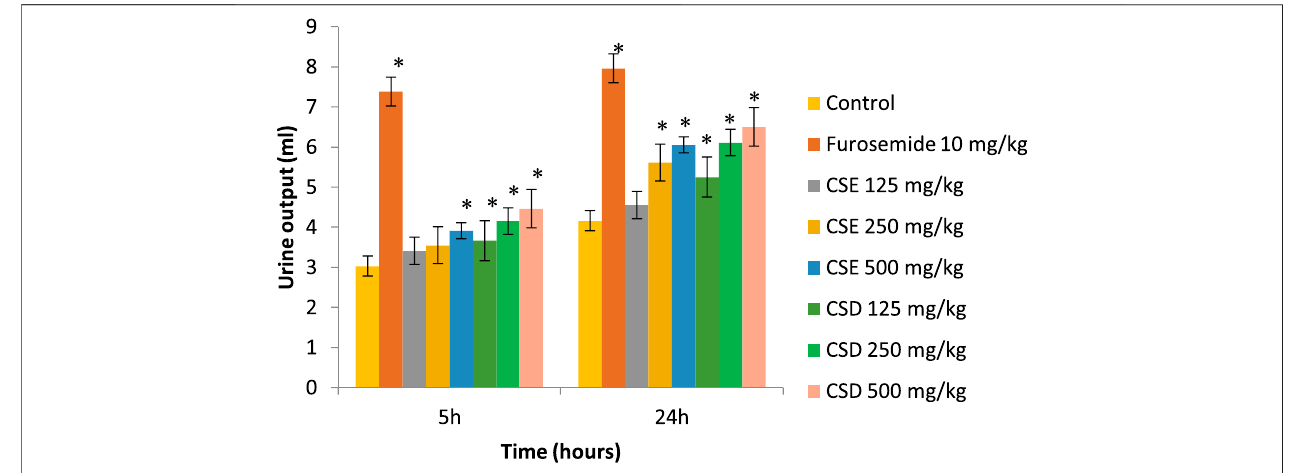
FIGURE2| Effectofthecherrystemsextract(CSE)andcherrystemsdecoction(CSD)onurineoutputrecordedat5and24 hinsaline-loadedCrl:WIrats(* p < 0.05 vs. saline control).